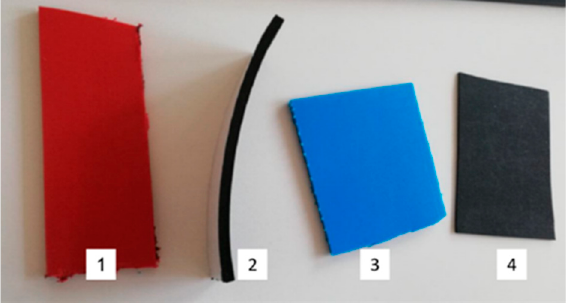
Figure 3. Photograph of polymeric samples (1: polypropylene. 2: neoprene. 3: polyethylene. 4: butyl rubber) which were used for the material compatibility experiments.